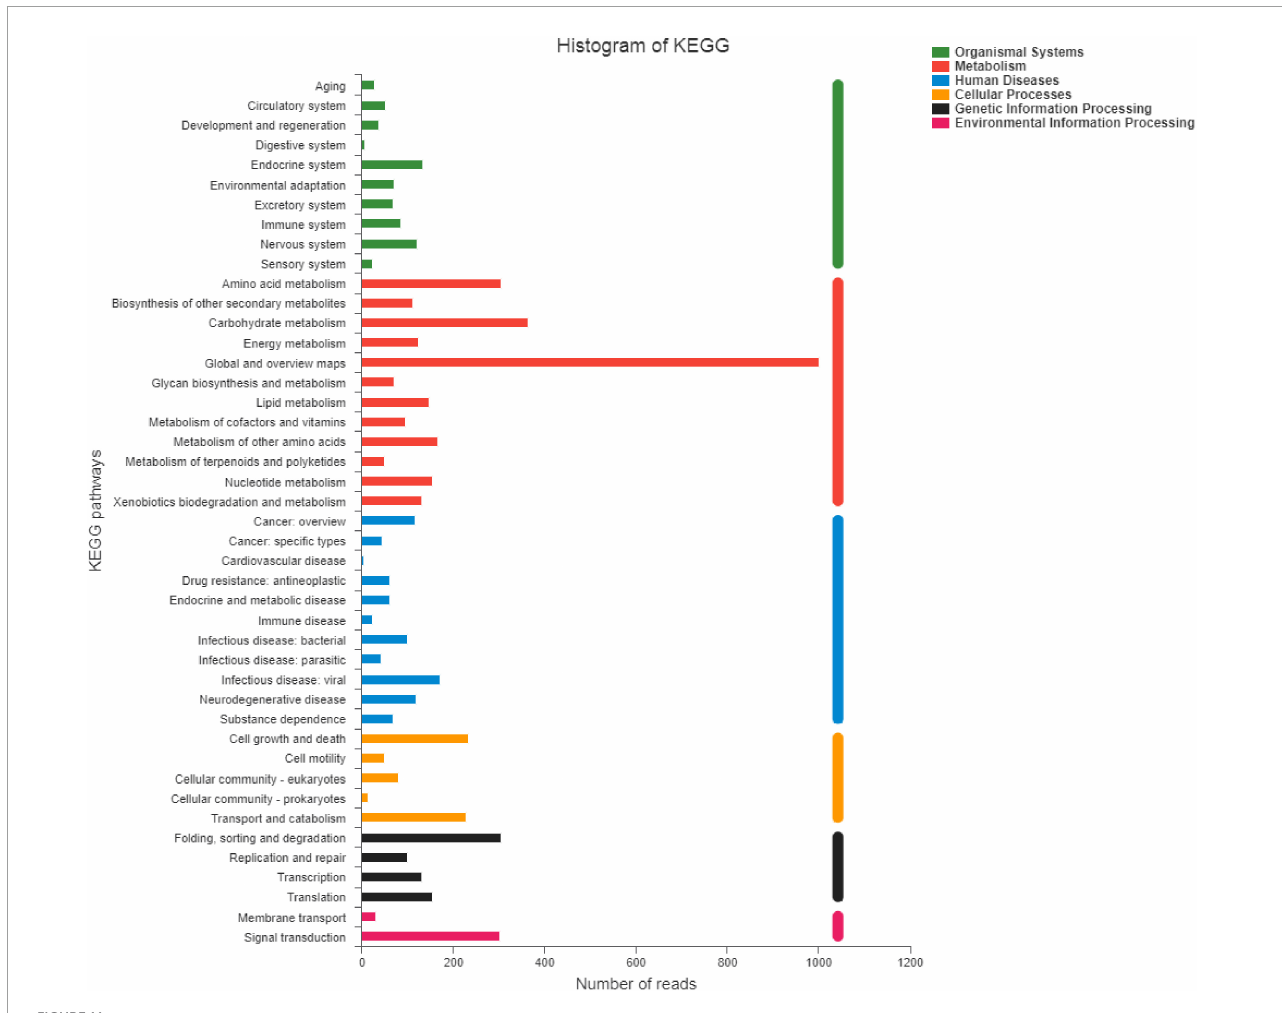
FIGURE11 Pathway classification statistics of Wickerhamomyces anomalus